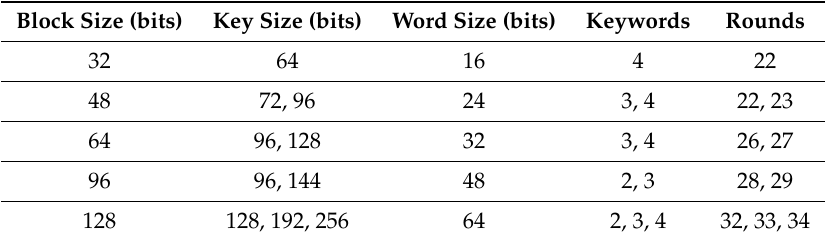
Table 5. Parameters of